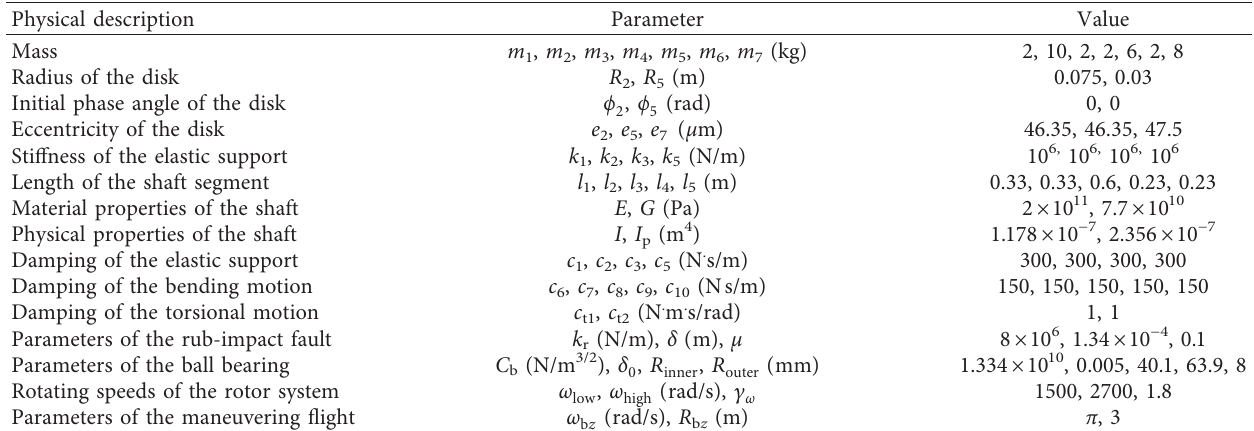
Table 1: Parameters of dual-rotor model.